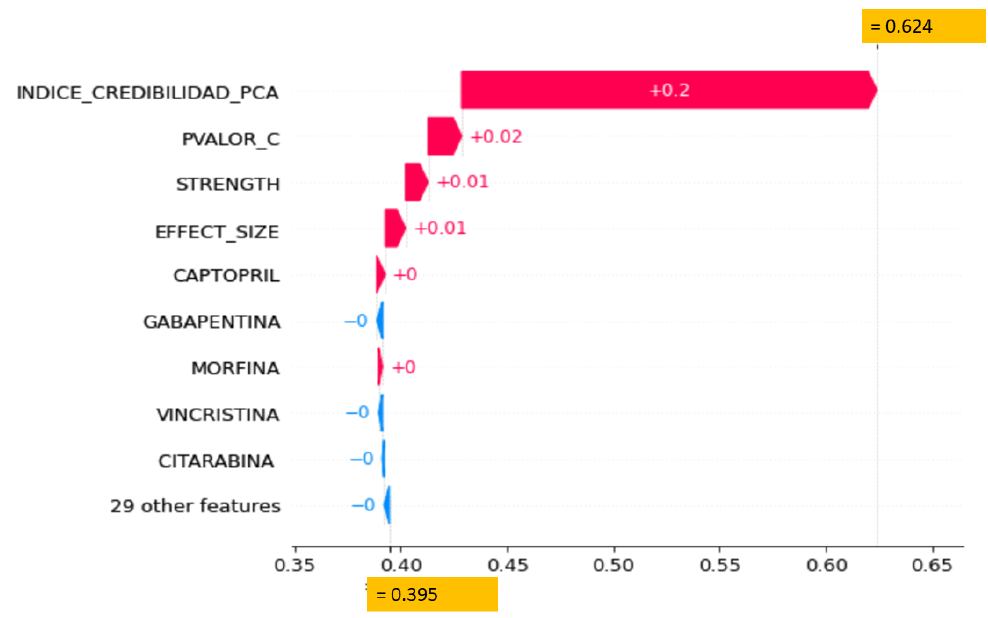
Figure 19. SHAP patient perspective.